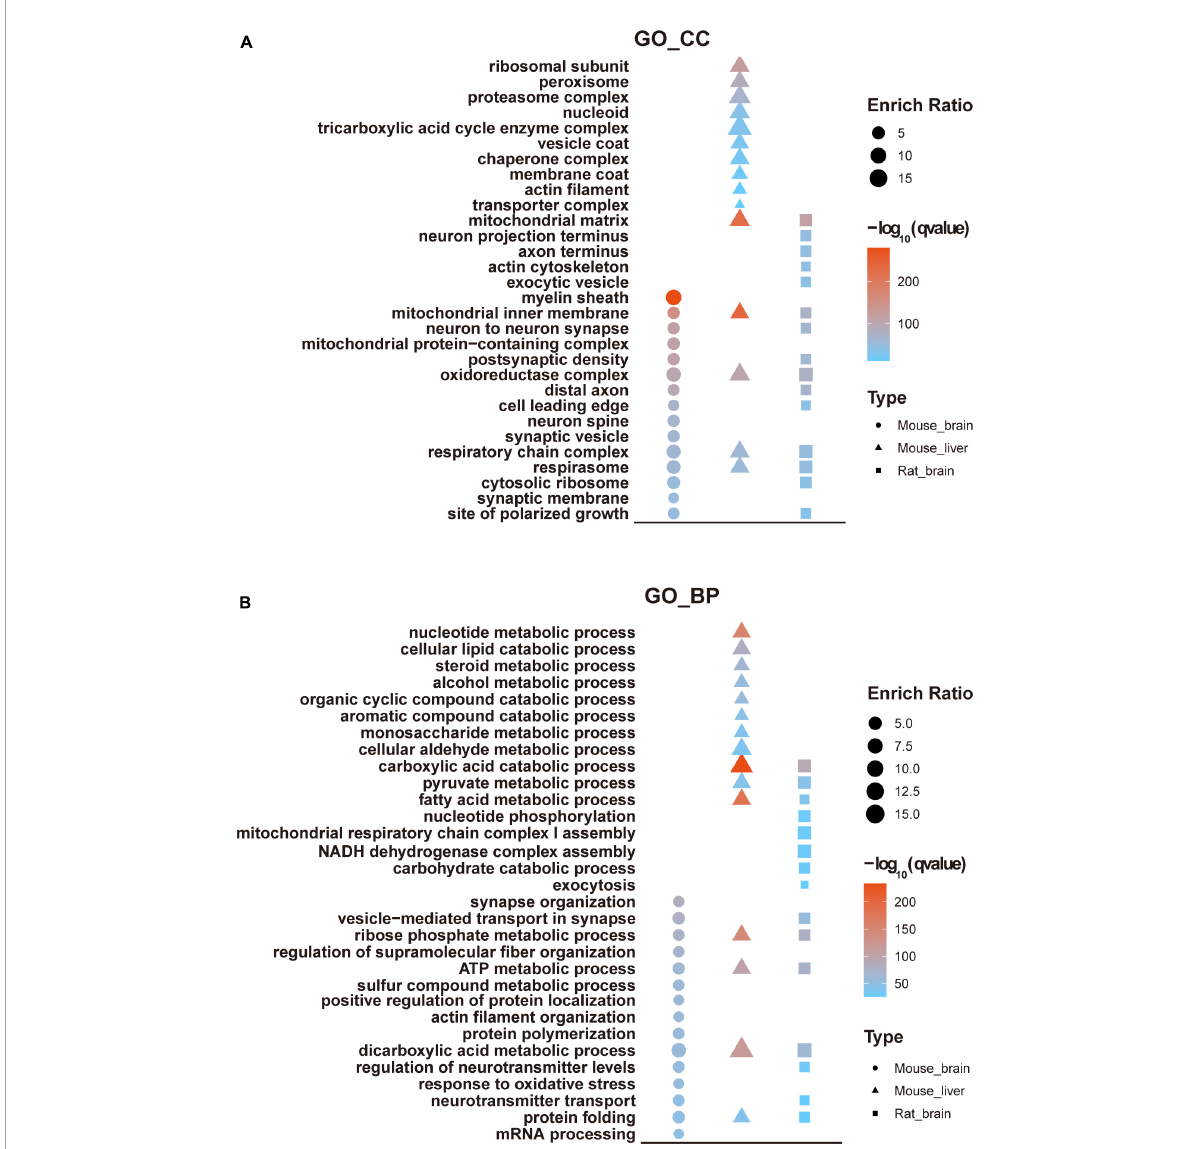
FIGURE5 GO enrichment analysis of mouse brain acetylome. GO enrichment analyzed cellular components (A) and biological processes (B) of the acetylome of the mouse brain and compared them with the rat brain and mouse liver.